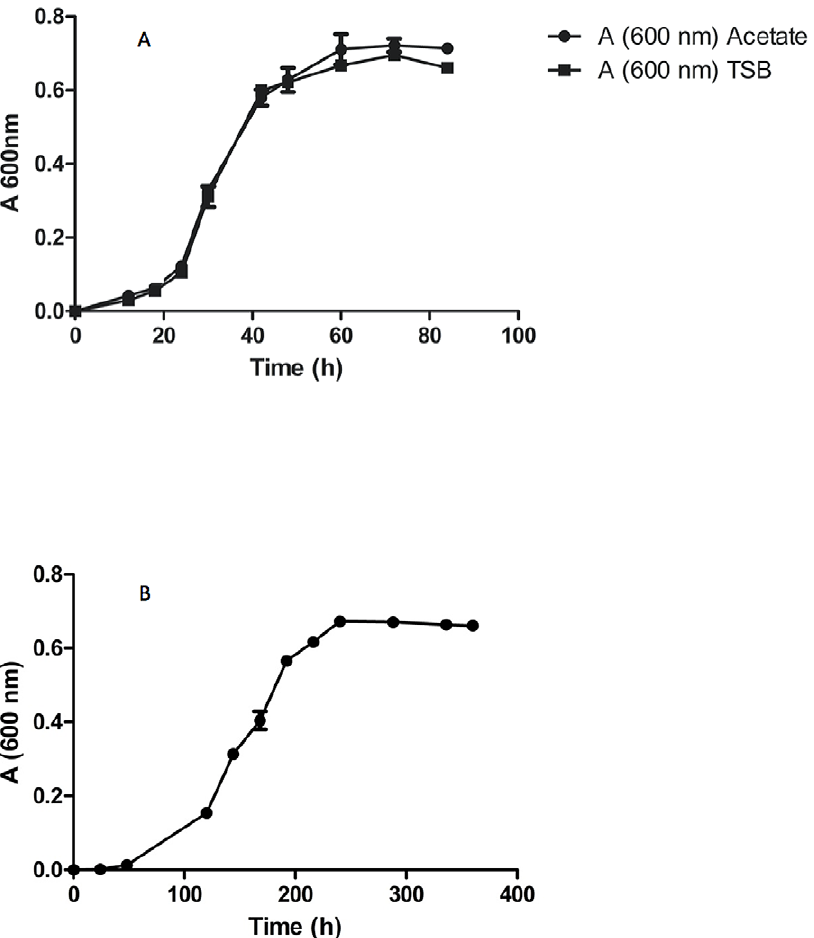
Figure 1. Growth curves of strain OM5 under the three different growth conditions. (A) acetate medium and TSB; (B) syngas. Error bars indicate standard error.